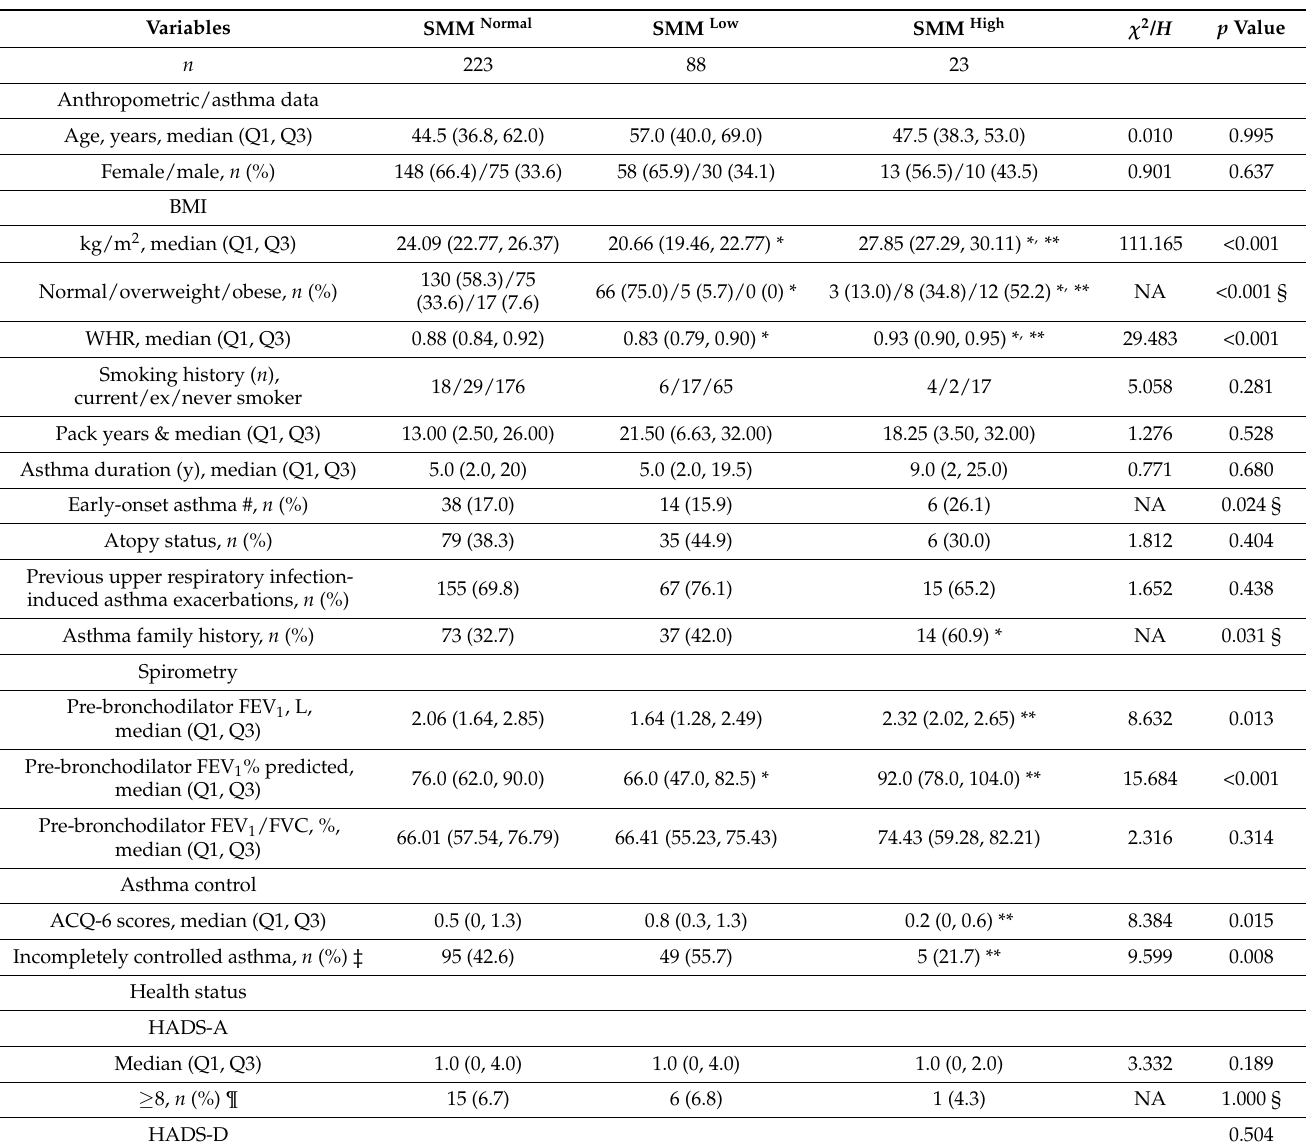
Table 1. Demographic and clinical characteristics of the included patients grouped by